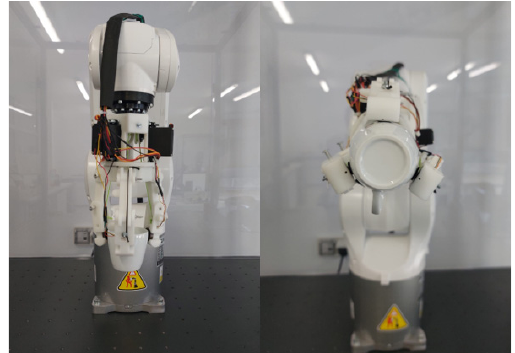
Figure 12. Display of the base of the cup. Source: (own).